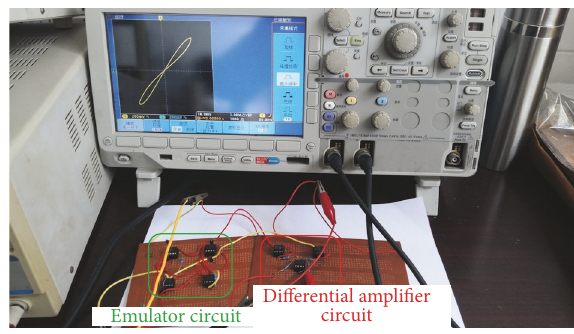
Figure 5: Experimental testing